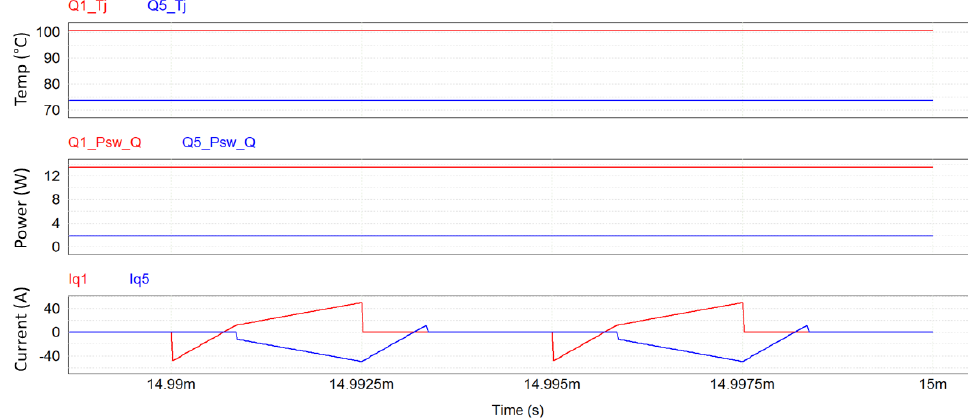
Figure 10. Junction temperatures, switching power losses, and drain current of Q1 and Q5, with a 40 ◦ C ambient temperature at point D P out = 5.33